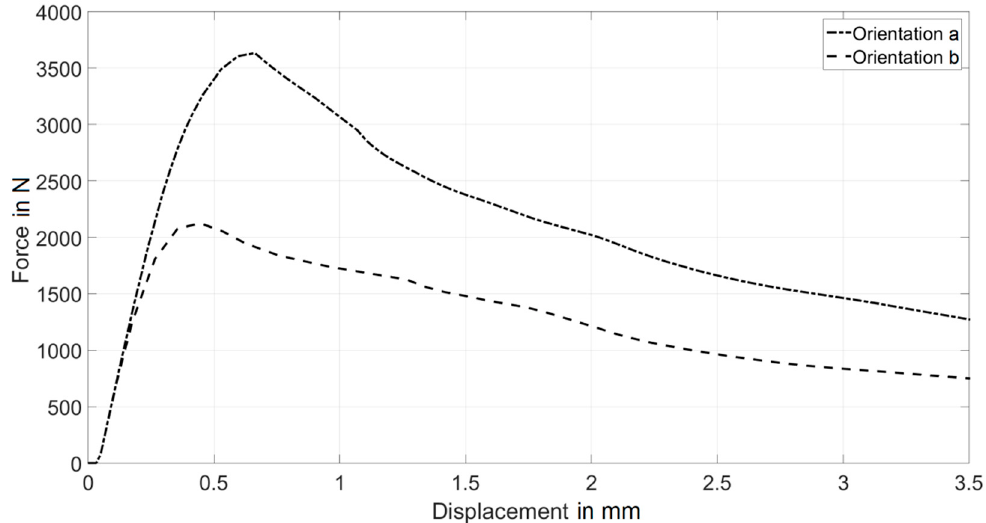
Figure 5. Force displacement curves resulting from the two numerical models of the three-point bending test with different fiber orientations.